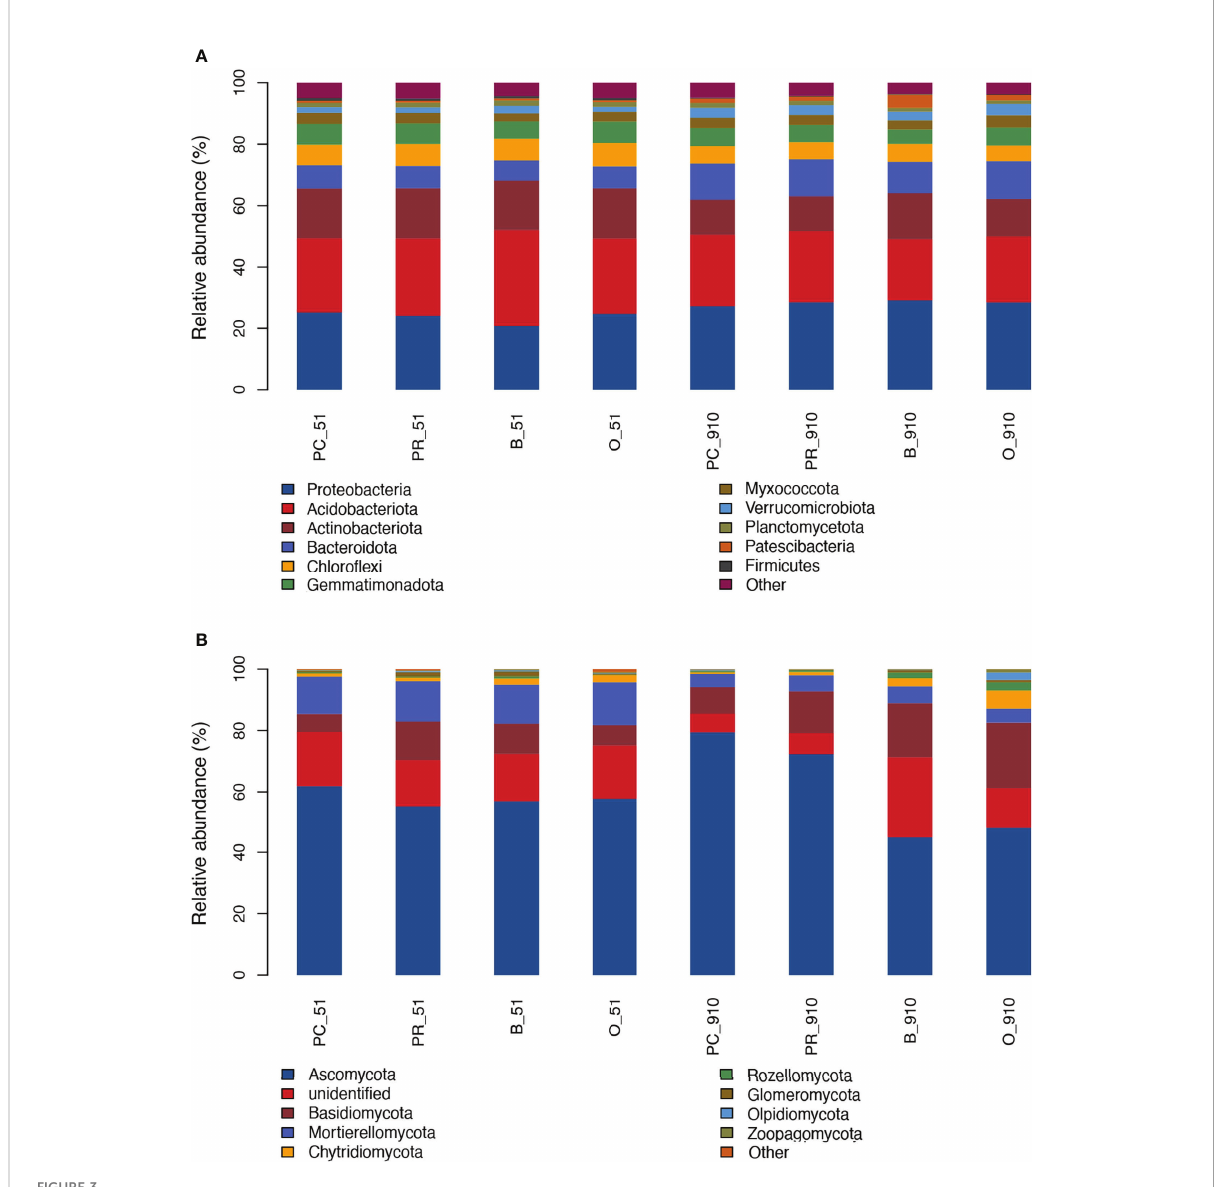
FIGURE 3 Bacterial (A) and fungal (B) community structure at the phylum level. B_51, O_51, PC_51 and PR_51 indicate the samples from B, O, PC and PR treatments at pre-planting, respectively; B_910, O_910, PC_910 and PR_910 indicate the samples from B, O, PC and PR treatments at